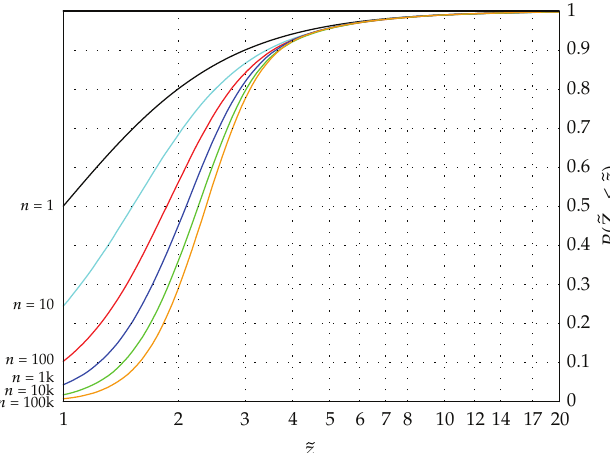
(cid:20) Figure 2: Plot of the probability pr (cid:2) Z n ≤ (cid:20) z (cid:3) for 1 ≤ (cid:20) z ≤ 20. The probability is computed with 10 6 Monte Carlo simulations. The curves from the top to the bottom correspond to n (cid:4) 1 , 10 , 10 2 , 10 3 , 10 4 , and 10 5 .